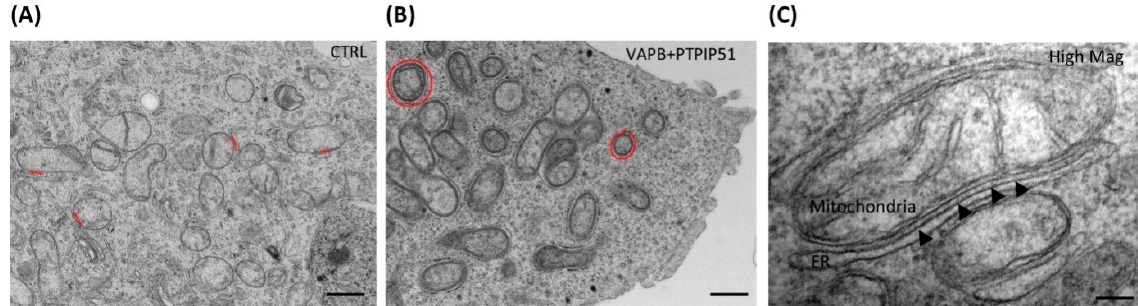
Figure 2. Representative electron microscope image of MAM in NSC34 motor neuron cells [51] (reused as per the Trends in Neuroscience journal’s copyright permission policy under the terms of the Creative Commons CC-BY license). Scale bars = 500 nm ( A , B ) and 100 nm ( C ). The figure represents the presence of MAM structures that form a close apposition between ER and mitochondria and the alteration in the cells that might occur as a result of altered protein function within the MAM. ( A ) Depiction of the control cells (CTRL), along with cells transfected with VAPB and PTPIP51. ( B ) ER–mitochondria associations are highlighted in red, demonstrating a drastic increase between MAM associations due to VAPB–PTPIP51 transfection. ( C ) The figure represents a high-magnitude image displaying the close contacts between ER and mitochondria to form the MAM.